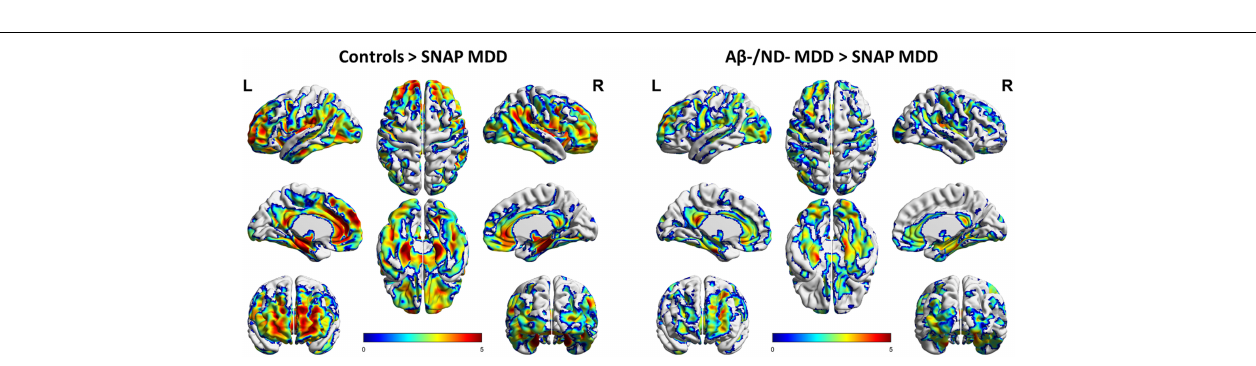
FIGURE 2 | Voxel-wise comparisons of 18 F-florbetapir uptakes in the SNAP ( n = 23) and A β –/ND– MDD ( n = 23) patients and controls ( n = 22) using data of partial volume correction (PVC). Voxel-wise analyses were performed, including age, gender and level of education as covariates. Shown are T-maps using false discovery rate (FDR) correction for multiple comparisons (p FDR < 0.05), with 3D brain renderings of 18 F-florbetapir PET analysis on the ch2 template brain. Renders were created using BrainNet Viewer (https://www.nitrc.org/projects/bnv/).